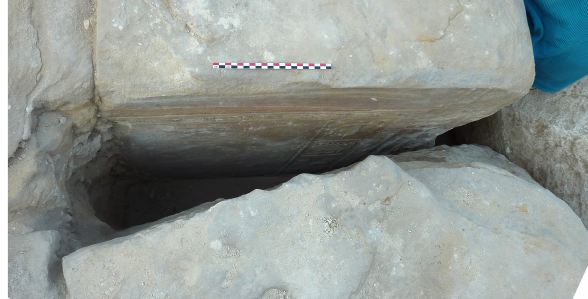
6: Screenshot of the textured model and camera